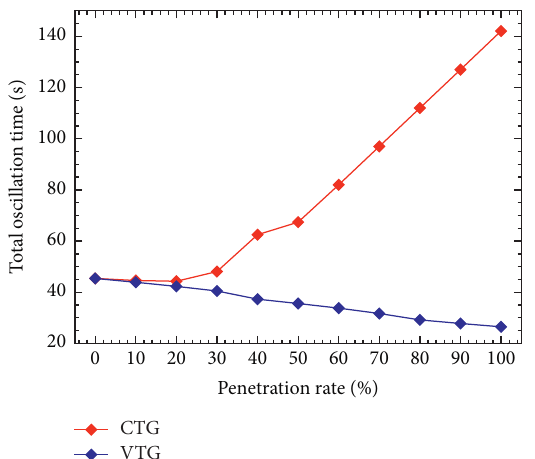
Figure 6: Comparison of the total oscillation time for the platoon with different desired time gap